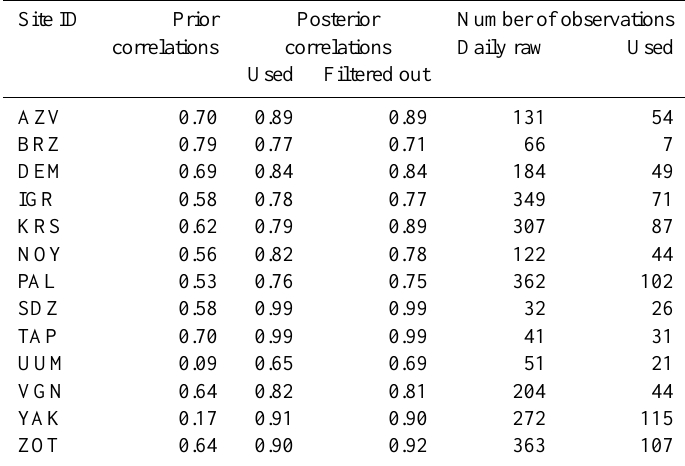
Table 2. Correlations of observed and simulated mixing ratios, prior and posterior to the inversion. Posterior correlation coefficients r are presented for the filtered data points used in the inversion, but also for those filtered out. The number of daily available observations is also reported alongside with the number of data used in the